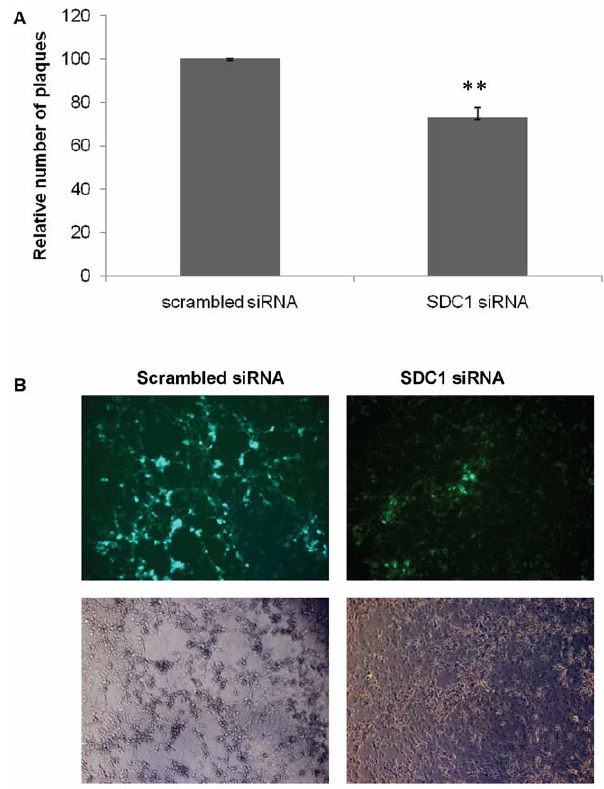
Figure 7. Syndecan-1 downregulation reduces HSV-1 spread. Monolayers of HCE cells were exposed to (A) HSV-1 (KOS) or (B) HSV-1 (KOS) K26GFP strains at MOI of 5 at 37 u C to allow virus entry. 2 h post- infection, cells were washed, incubated for 1 min with 0.1 M citrate buffer (PH 3.0), then washed with PBS and overlaid with 0.5% methylcellulose medium. After 4 h, cells were washed, dissociated, and approximately 600 cells were plated onto 80% confluent monolayers of uninfected HCE cells that have been transfected with either scrambled siRNA or syndecan-1 siRNA for 72 h in 0.5% methylcellulose medium. (A). The spread of HSV-1 (KOS) from infected cells to the siRNA transfected HCE cells was evaluated by staining and counting the number of plaques formed at the 10 6 objective (Zeiss Axiovert 200). Results are presented as relative number of plaques (mean 6 1SD) of four independent experiments performed in duplicates. (B) HSV-1 (KOS) K26GFP spread was qualitatively assessed at the 10 6 objective (Zeiss Axiovert 200). Representative images from one experiment performed in triplicate are shown. SDC1 , syndecan-1.